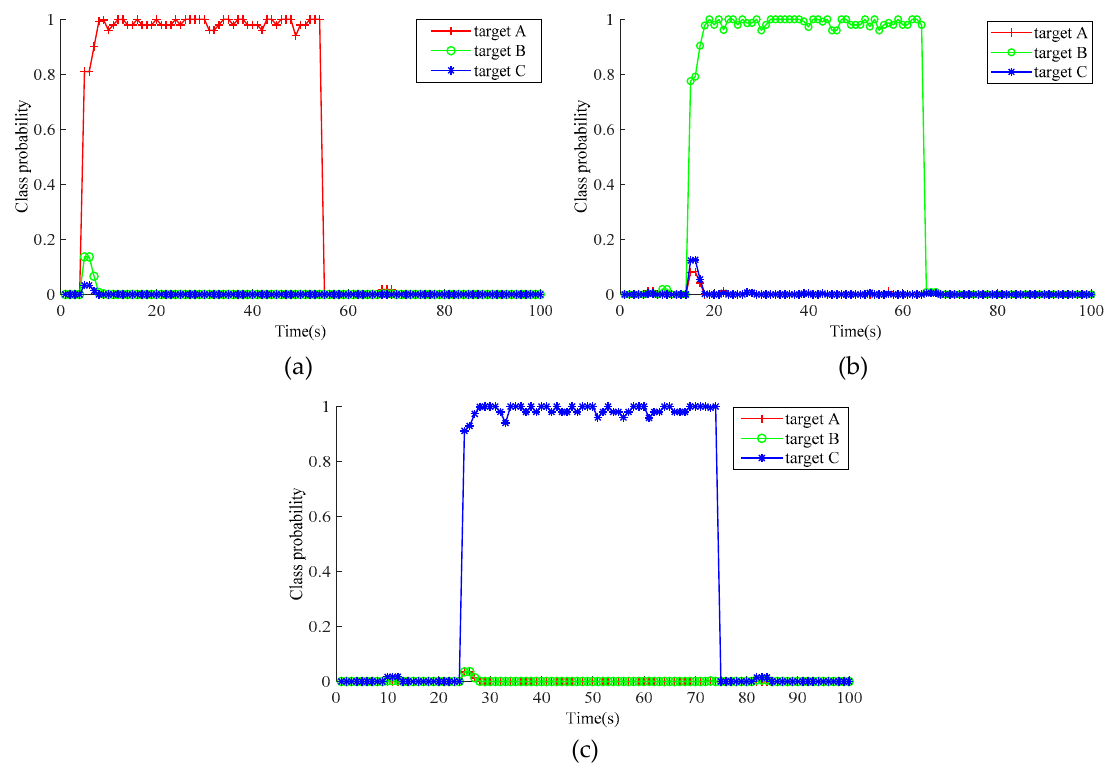
Figure 8. Results of targets classification: ( a ) Ship Target A; ( b ) Ship Target B; ( c ) Ship Target C.